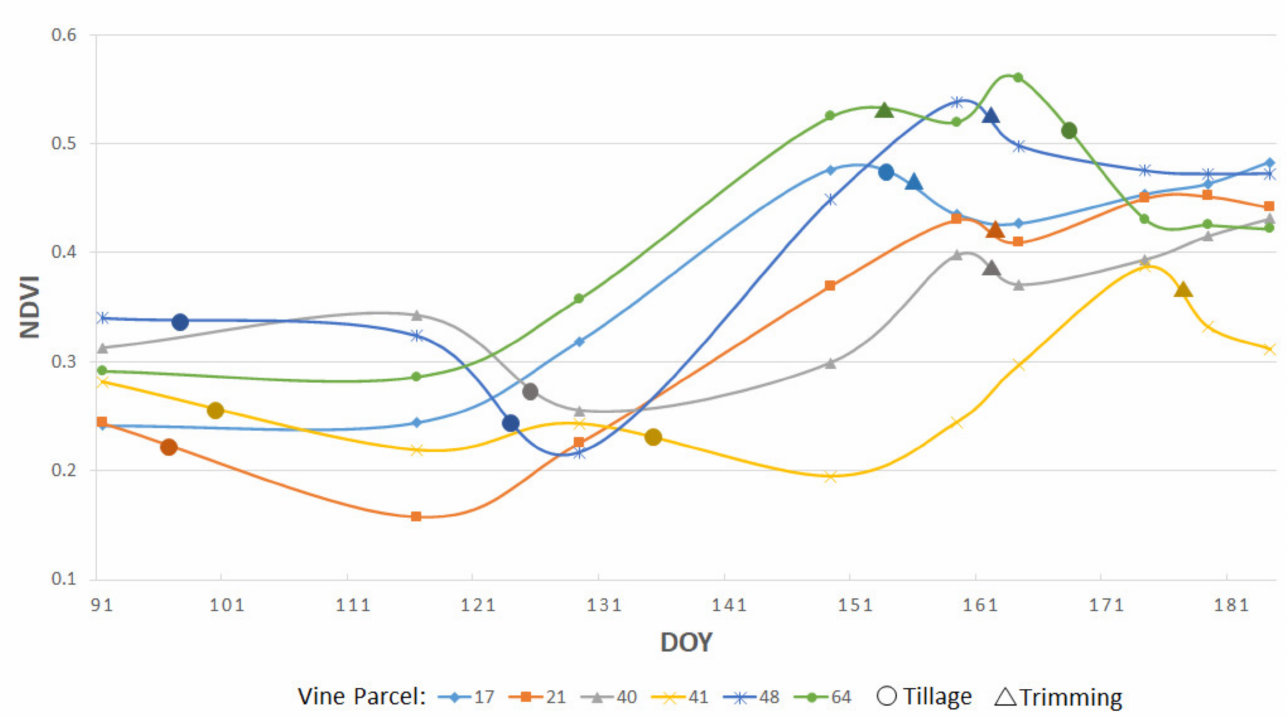
Figure 8. Temporal dynamic ranges of NDVI to vine growth for the six parcels of interest and main management applications related to weed and canopy